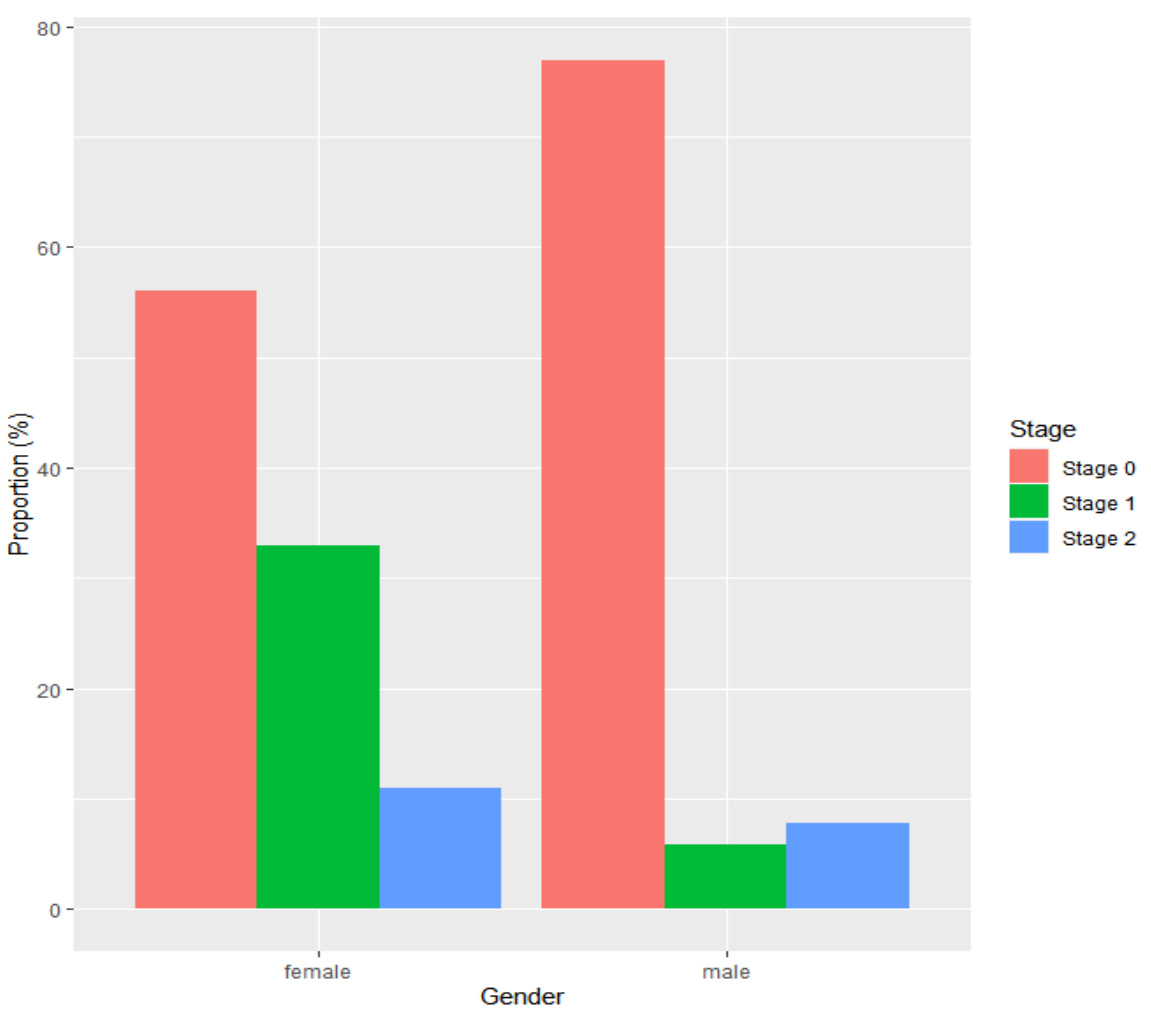
Figure 2. Stage distribution of neoplasia according to sex, with stage 0 including TisN0M0 and HGD, stage 1 including T1N0M0 and T2N0M0, and stage 2 including T3N0M0 and T1/T2N1M0. Data for 5 male patients were missing.